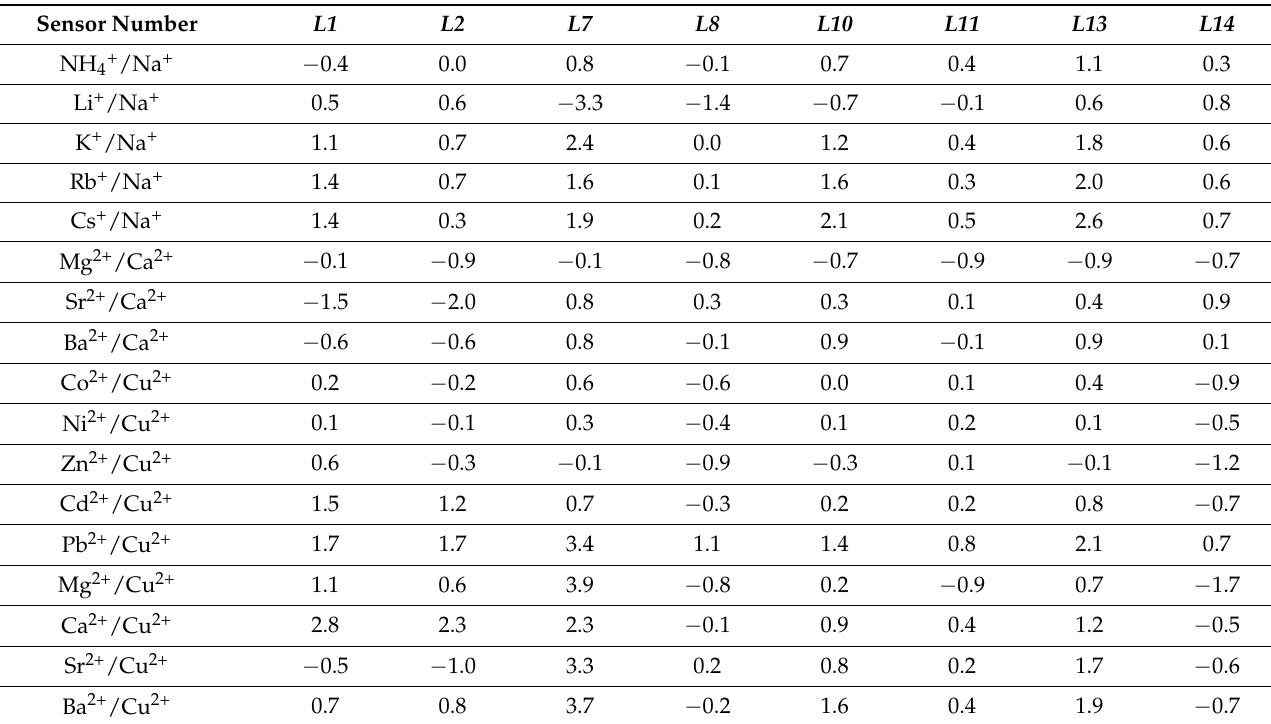
Table 3. logK pot values of the studied sensors ( ± 0.1 logK pot ij